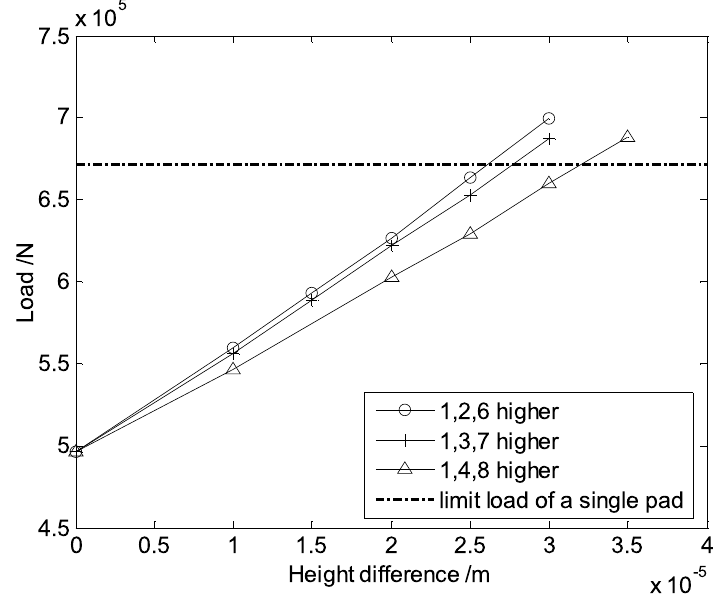
Fig. 13. Maximum load of all pads when three pads have larger